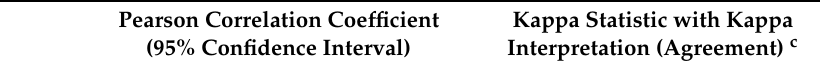
Table 2. Temporal sampling agreement of E. coli with the dry cloth method—across three months’ time within